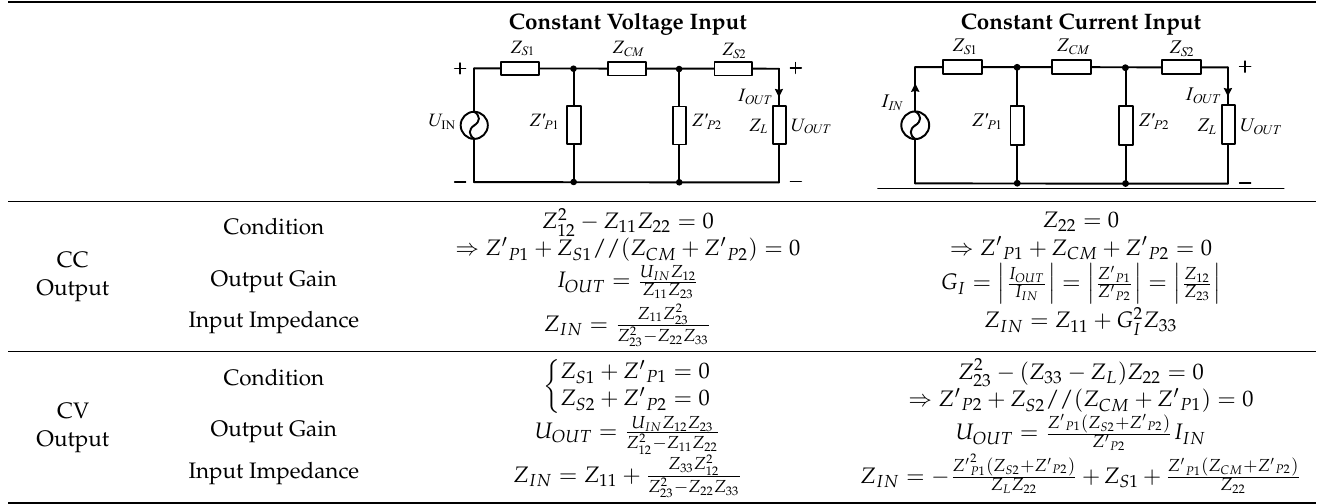
Table 1. Comparison of SP-based compensation topologies.